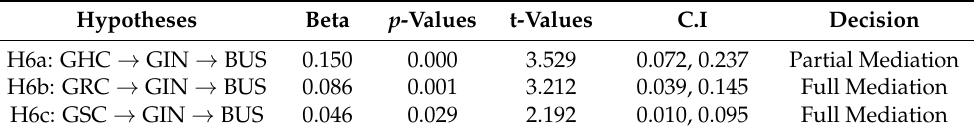
Table 10. Mediation